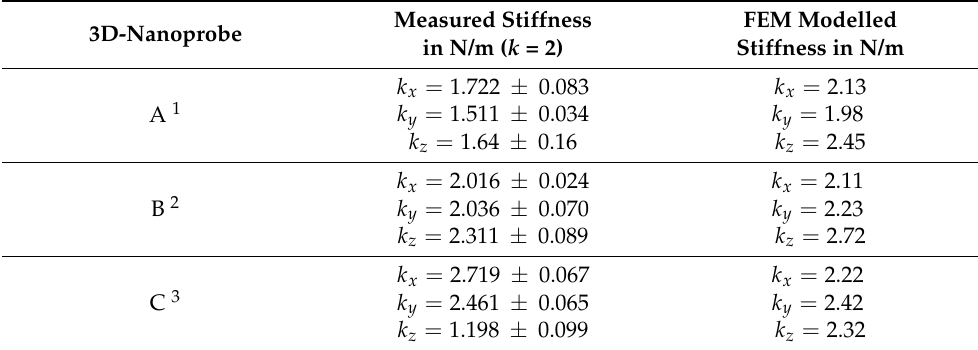
Table 1. Stiffness values of three manufactured 3D-Nanoprobes obtained by calibration and finite element method (FEM)